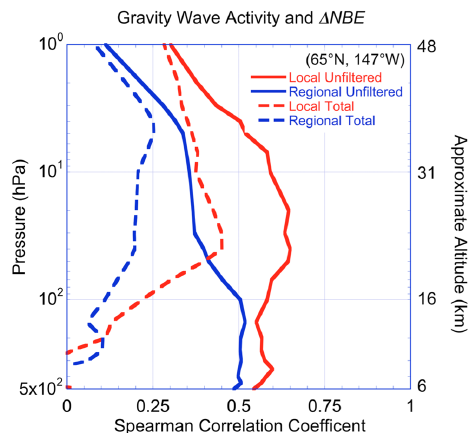
Figure 15. Spearman correlation of gravity wave-specific potential energy and ∆ NBE in altitude at Chatanika. “Local unfiltered” represents the correlation with ∆ NBE averaged over all of the area within 800 km of Chatanika with winds greater than 15 m/s (red solid). “Regional unfiltered” represents the correlation with ∆ NBE averaged over all of the area poleward of 50° N with winds greater than 15 m/s (blue solid). “Local total” represents the correlation with ∆ NBE averaged over all of the area within 800 km of Chatanika (red dashed). “Regional total” represents the correlation with ∆ NBE averaged over all of the area poleward of 50° N (blue dashed).